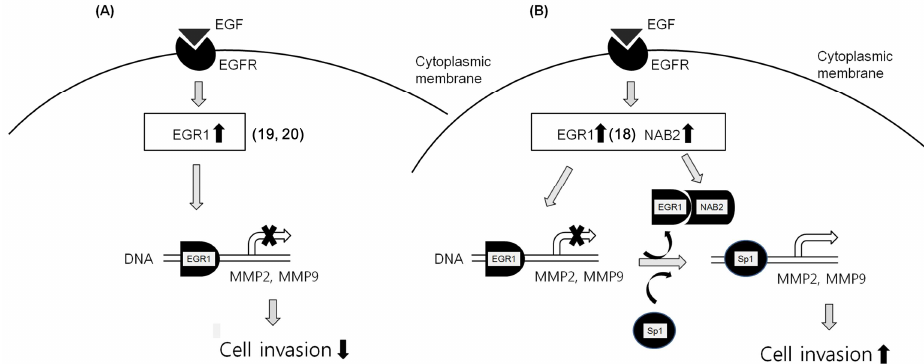
Figure 6. Putative schematic of EGF-EGR1-NAB2-dependent cancer cell invasion. ( A ) EGF-dependent EGR1 upregulation inhibits cancer progression by downregulating MMP. ( B ) However, EGF-dependent co-upregulation of EGR1 and NAB2 is presumed to form a complex in some cancer cells. This might result in the prevention of EGR1 binding to DNA consensus sequences, and its replacement with Sp1. Therefore, NAB2, a co-repressor of EGR1, permits EGF-mediated cancer invasion even with EGR1 upregulation.